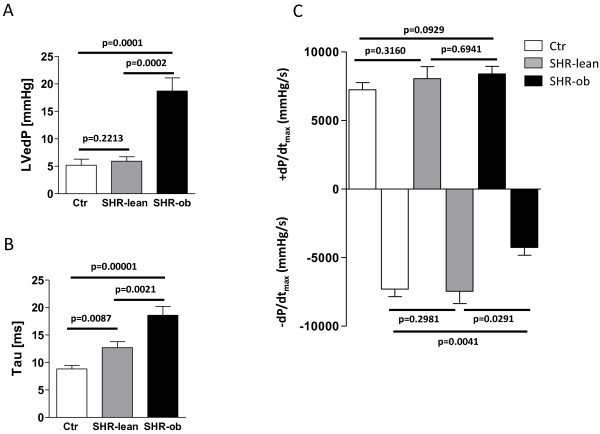
LV-function determined by invasive LV-measurement procedures: A) Left ventricular enddiastolic pressure (LVedP), B) left ventricular isovolumetric relaxation time constant (Tau), C) maximal (+dP/dtmax) and minimal (−dP/dtmax) pressure decay in controls (Ctr) (n = 10), SHR-lean (n = 8) and SHR-ob (n = 8). Data are presented in means ± SEM.